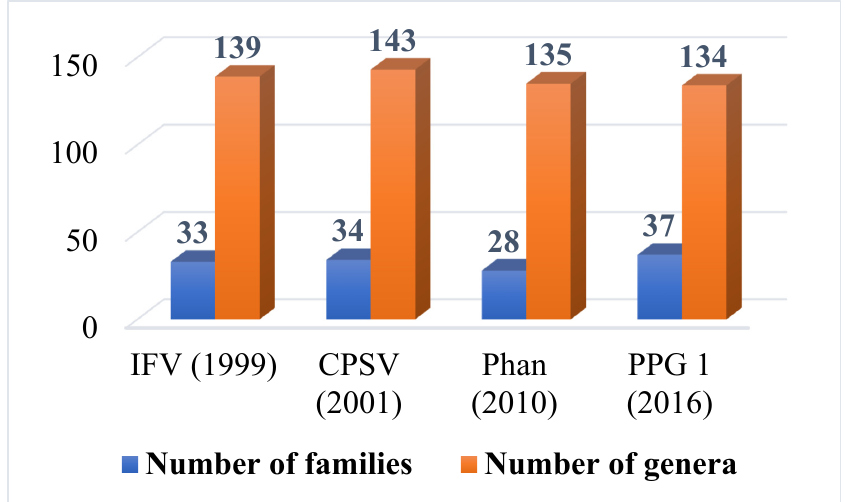
Figure 1. Number of families and genera of lycophytes and ferns in Vietnam according to different treatments.